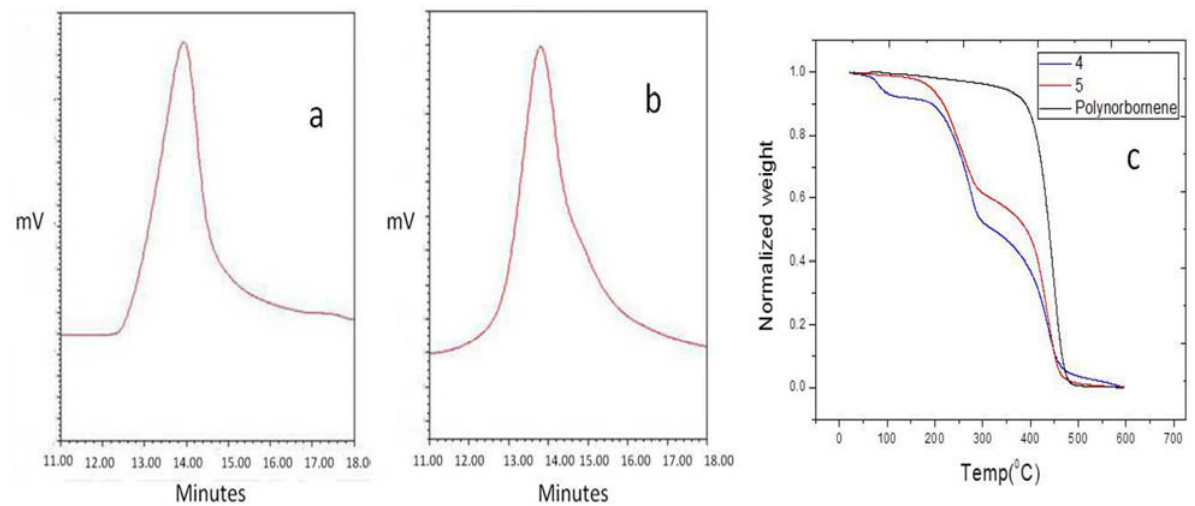
Figure 2. Gel permeation chromatography (GPC) analysis of the polymers ( a ) homopolymer 4; and ( b ) 1:1 diblock copolymer 5; ( c ) thermogravimetric analysis (TGA) of the